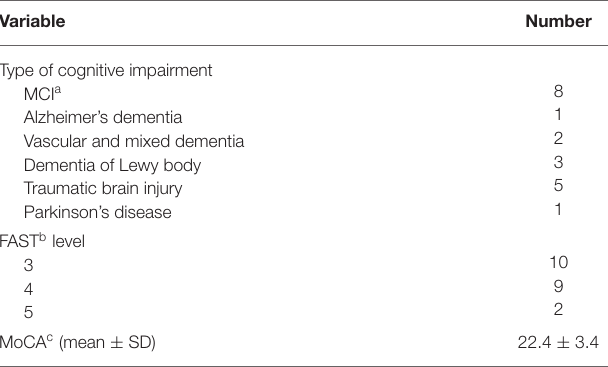
TABLE 2 | Clinical characteristics of patients.